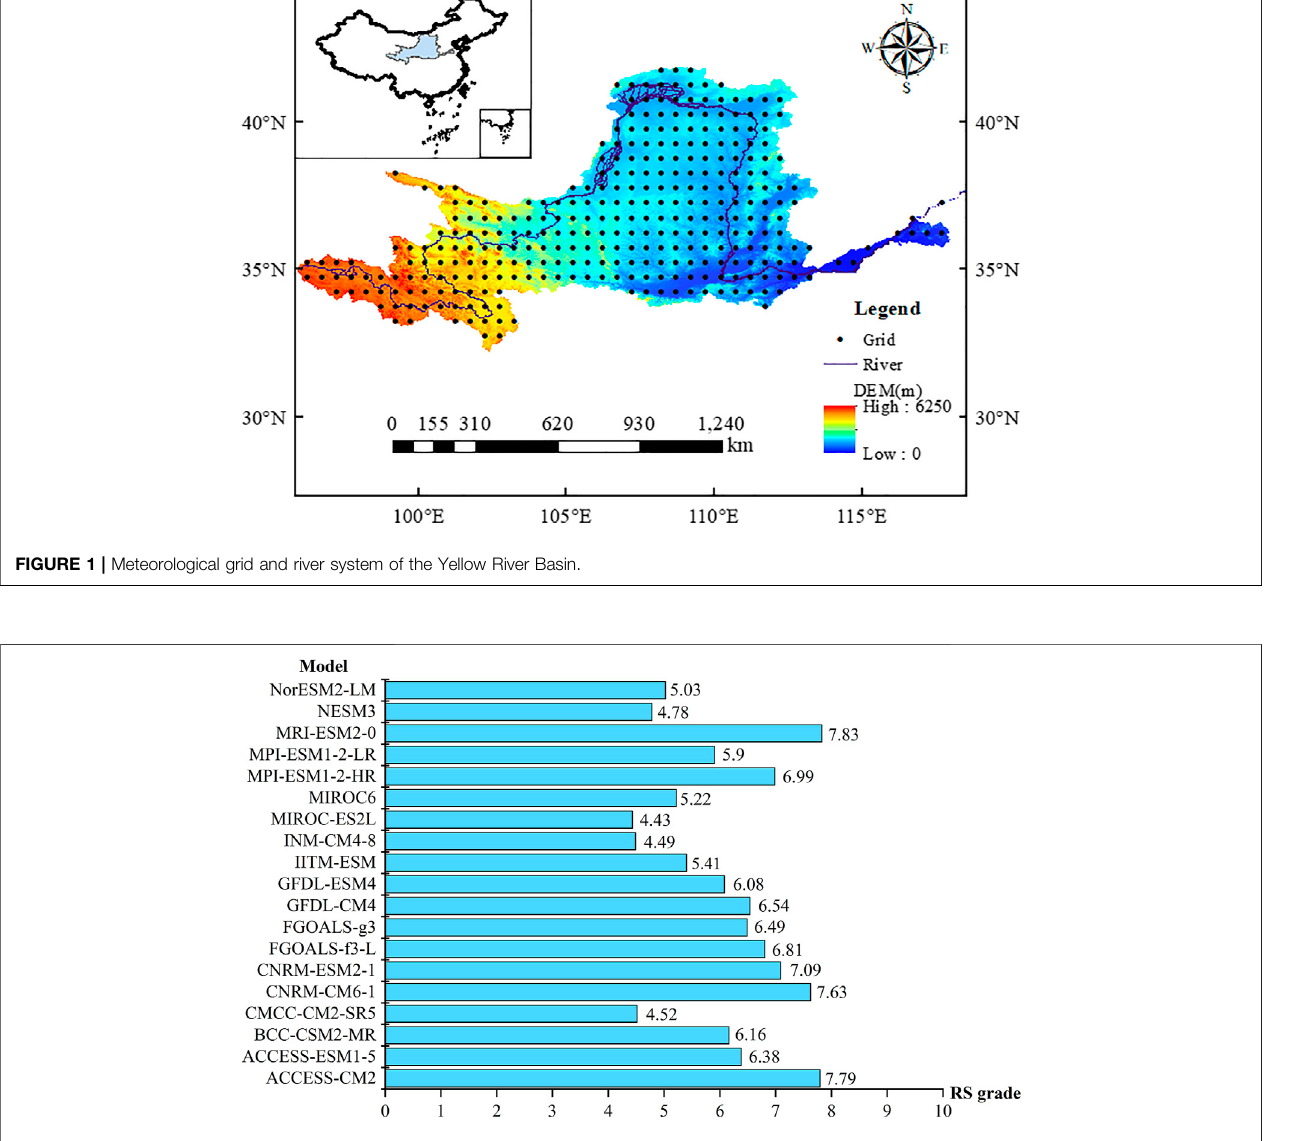
FIGURE 2 | RS scores of the 19 GCMs in